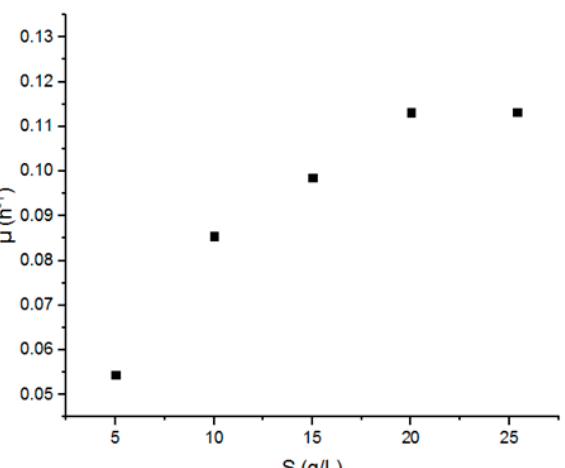
Figure 1. The variation of the specific growth rate µ as a function of the substrate concentration S (5–25 g.L − 1 ).